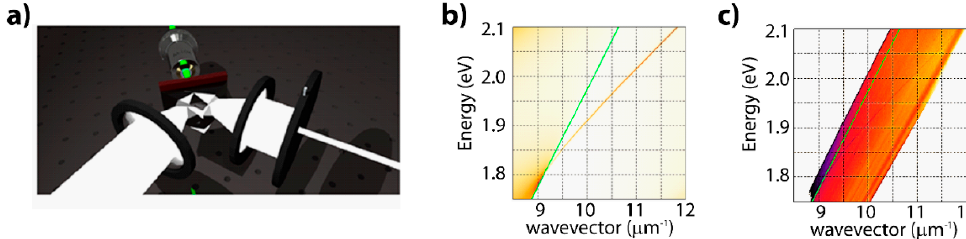
Figure 1. ( a ) Schematic drawing of the experimental setup used for reflectivity and emission measurements in Kretschmann configuration. (Reproduced with permission from [38], OSA Publishing, 2014). ( b ) TMM calculation of the BSW reflectance dispersion using a DBR composed of five pairs of TiO 2 /SiO 2 (101 nm/138 nm) with and additional top-pair of TiO 2 /SiO 2 (14 nm/16 nm). The light line (green line) corresponds to an angle of about 42 degrees in glass; the Bloch surface mode is the dip visible in the total internal reflection regime (yellow line on the right side to the green line). ( c ) Experimental reflection signal. A very shallow BSW curve is visible, in a perfect agreement with the computation in ( b ).